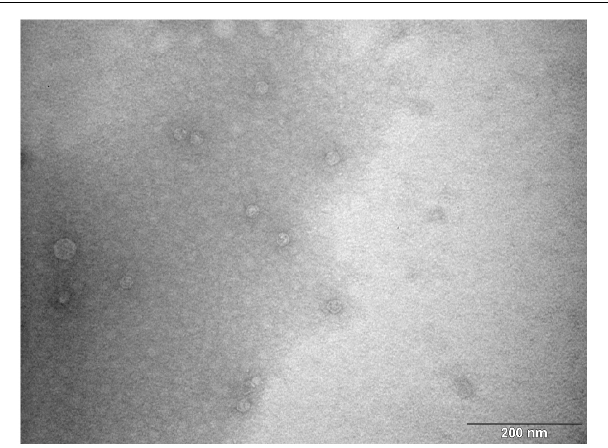
FIGURE 6 | Transmission electron microscopy photograph of homogenous and non-aggregated MS2 phage-like particles (MS2 PLP). The scale is 200